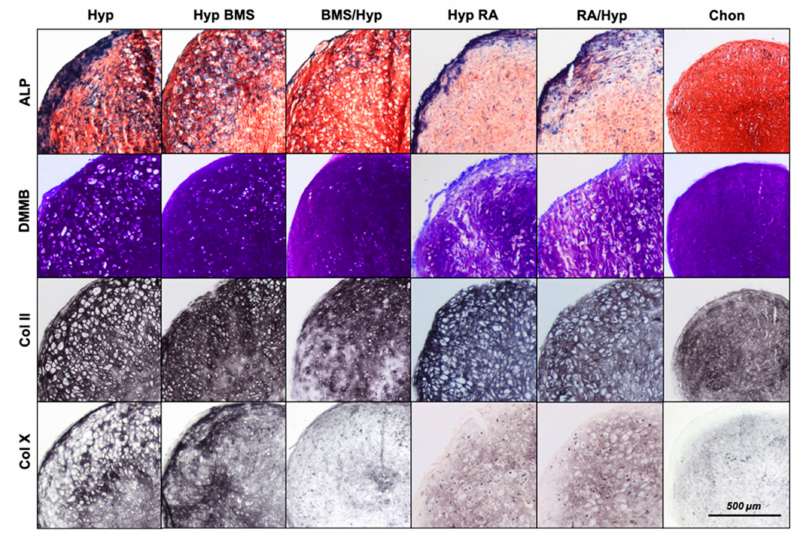
Figure 3. E ff ect of BMS and RA to the histological appearance of mesenchymal stem cells (MSC) aggregates on Day 28. First line ALP staining; second line DMMB staining; third line immunohistochemical collagen type II staining; fourth line immunohistochemical collagen type X staining. Scale bar = 500 µ m. ALP, alkaline phosphatase; DMMB, dimethylmethylene blue; Coll II, collagen type II; Coll X, collagen type X; Chon, chondrogenic control group; Hyp, hypertrophic control group; Hyp BMS, hypertrophic group with late BMS treatment; BMS / Hyp, hypertrophic group with early BMS treatment; Hyp RA, hypertrophic group with late retinoic acid treatment; RA / Hyp, hypertrophic group with early retinoic acid